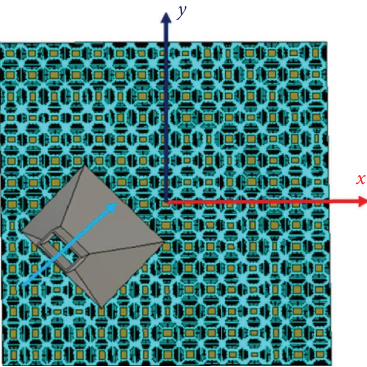
Figure 13: Refectarray antenna simulation model diagram.